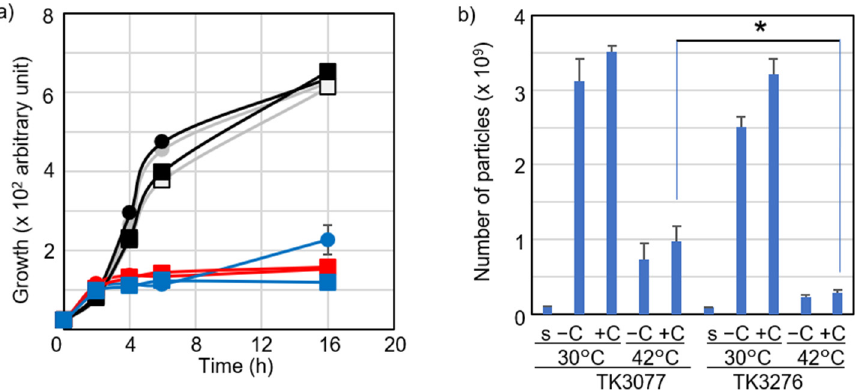
Figure 2. Vitamin C effect on recAts polA cell growth in permissive and restrictive conditions. ( a ) Optical growth inhibition at a restrictive temperature in shift-up experiments. The growth curves for the shift-up experiment at the logarithmic phase are shown. The changes in turbidity (O.D. 600 arbitrary unit) over time can be seen, starting when the culture medium is divided. TK3077 and TK3276 cells are indicated using circles and squares, respectively. The progression of cell growth is indicated by lines colored gray (without vitamin C) and black (with 100 µ M vitamin C) for treatments at 30 °C. Lines are colored red (without vitamin C) and blue (with 100 μ M vitamin C) for treatments at 42 °C. Each point is shown as the average and standard error of the mean (SEM) (n ≥ 3). ( b ) Cell proliferation inhibition at a restrictive temperature in shift-up experiments. Cells cultured for 16 h were measured (particles/mL) using flow cytometry. Treatment combinations are shown from left to right: seed culture (s), cell culture without vitamin C ( − C), or cell culture with 100 mM vitamin C (+C) at 30 °C and 42 °C for TK3077 and TK3276 cells. Each bar represents the average and standard error of the mean (SEM) (n ≥ 3). * p < 0.05, according to Welch’s t- test (n = 6).